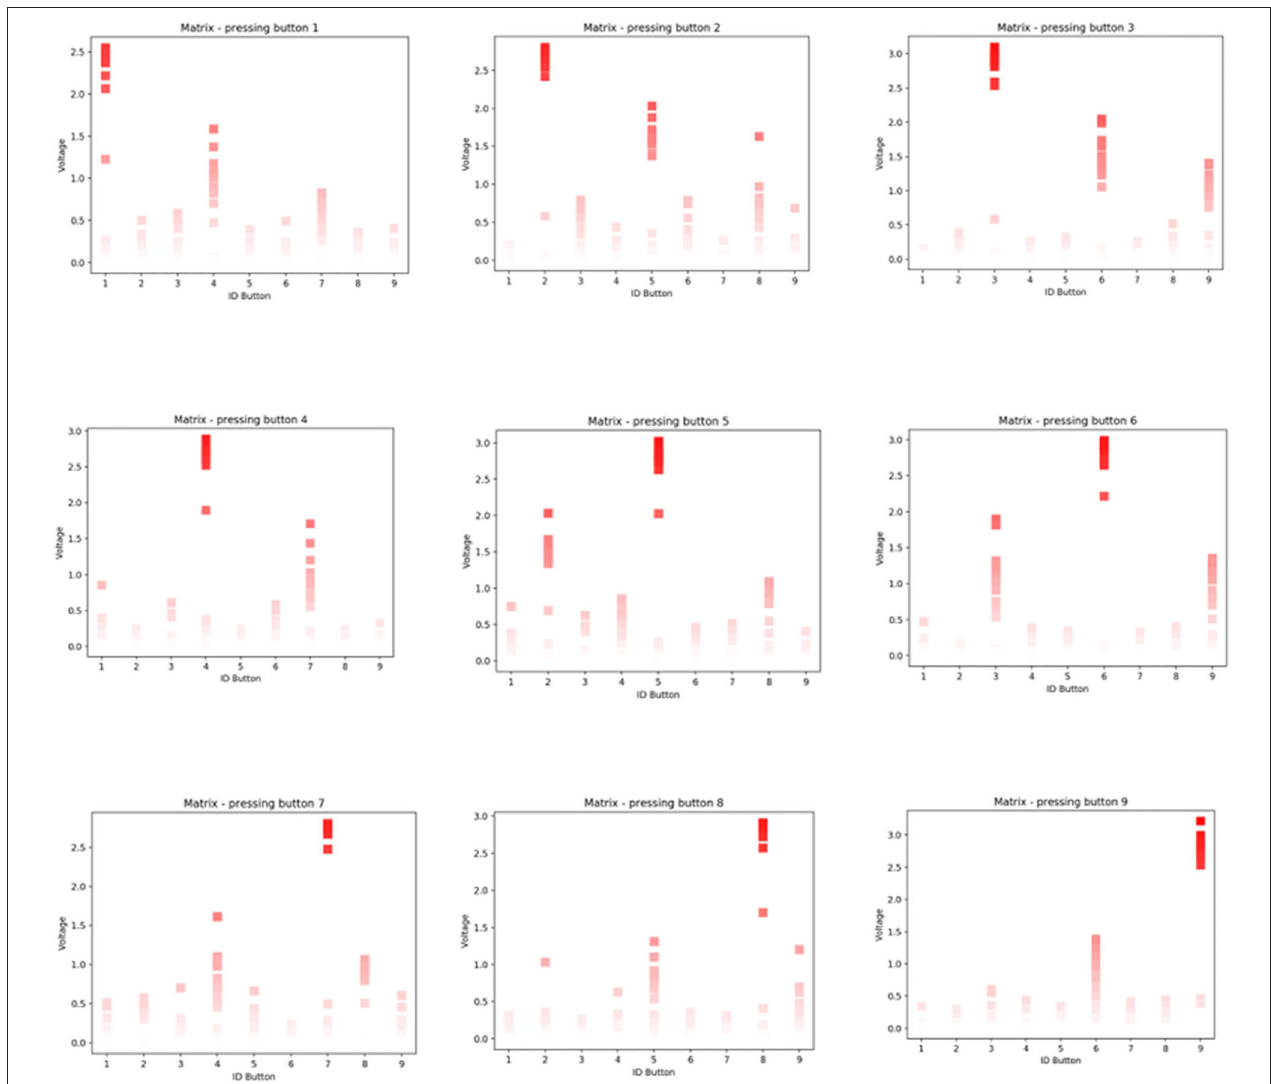
FIGURE 10 | Readings of individual buttons on the